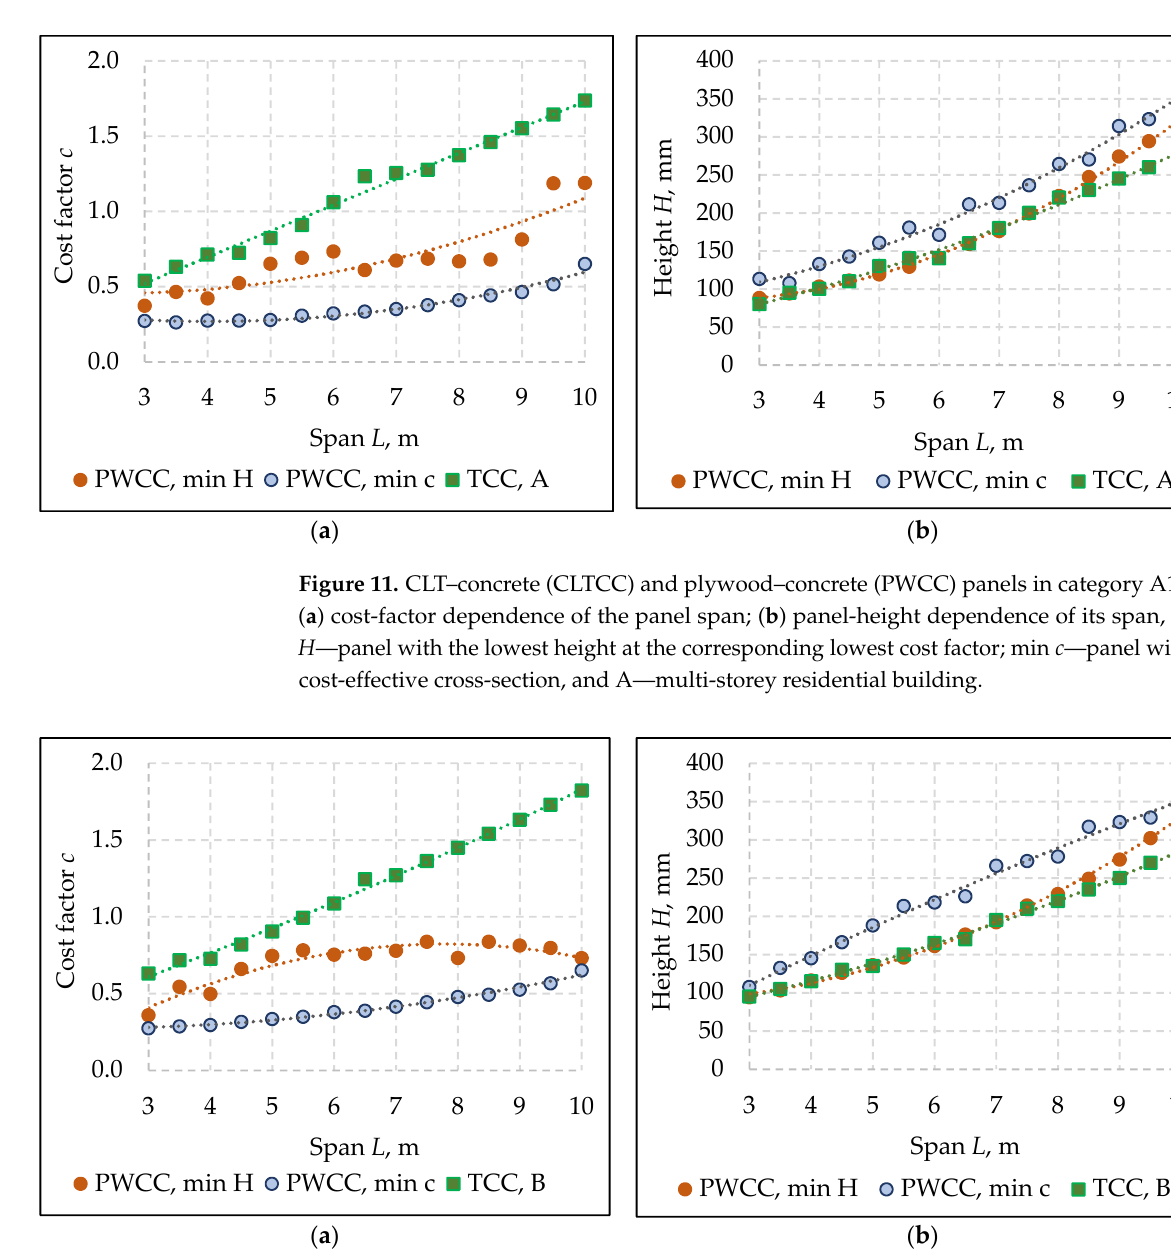
Figure 12. CLT–concrete (CLTCC) and plywood–concrete (PWCC) panels in category B buildings: ( a ) cost-factor dependence of the panel span; ( b ) panel-height dependence of its span, where min H —panel with the lowest height at the corresponding lowest cost factor; min c —panel with the most cost-effective cross-section, and B—office building. A comparison of the 1-meter-wide strip self-weight of TCC with CLT base and equiv- alent self-weight of TCC with plywood rib panel base with the most cost-effective cross- sectional parameters is shown in Figure 13.